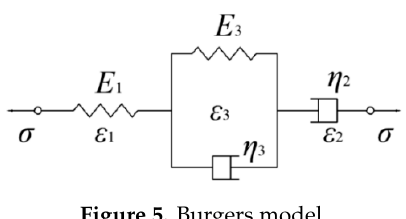
(1) Figure 4. Stress-strain curve of the DMA tensile strain scanning. 3. Results and Discussion In the cutting and building process of the uncured rubber compound, it was kept at a temperature of − 20 °C and linear macromolecules had not been cross-linked, so its viscoelasticity was closer to a fluid than a solid. Therefore, the four-element model (Burgers model) was chosen for analysis. The Burgers model is essentially formed by connecting a Maxwell model representing fluid